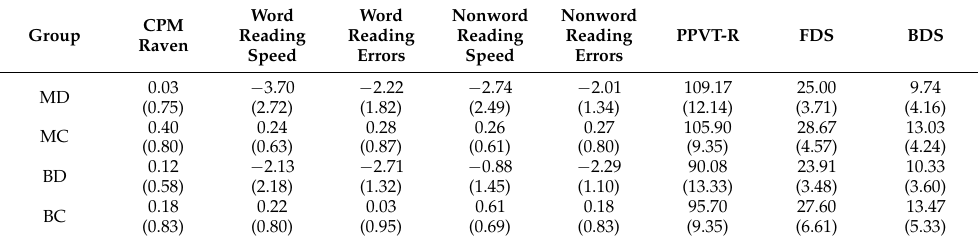
Table 3. Means (SDs) of the three groups in the preliminary